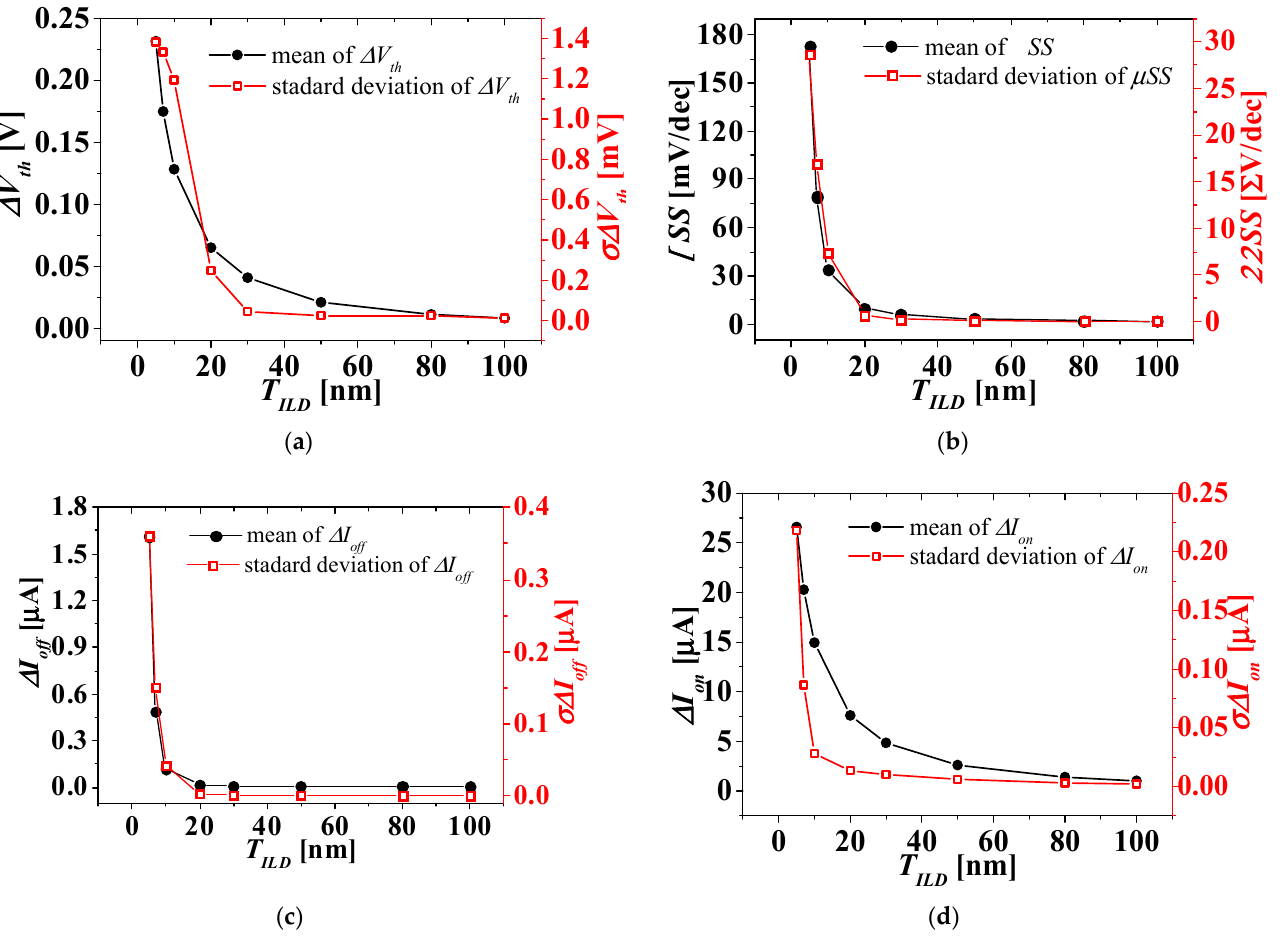
Figure 9. Means (left axis) and standard deviations (right axis) considering WFV on the MoN gate of the bottom-tier PMOS only. ( a ) Δ V th , ( b ) Δ SS, ( c ) Δ I off , and ( d ) Δ I on .